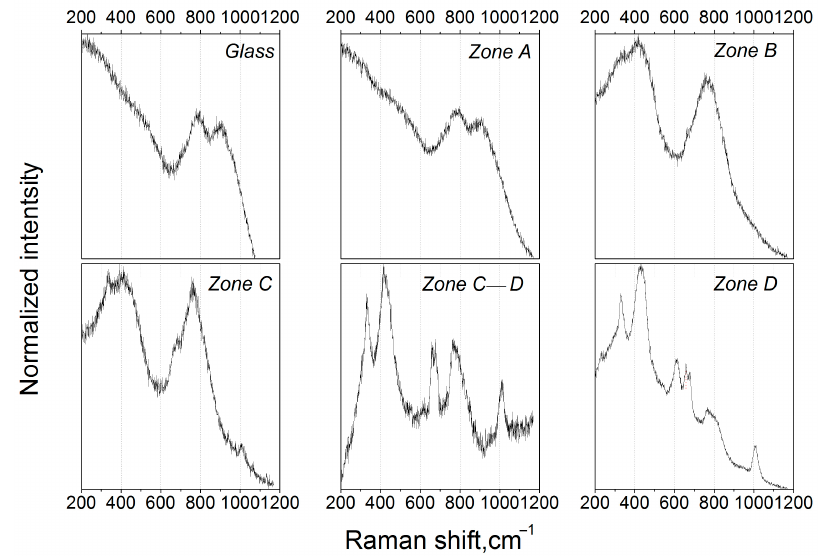
Figure 3. Raman spectra recorded from different zones of the glass sample (symbols A–D correspond to Figure 2a).